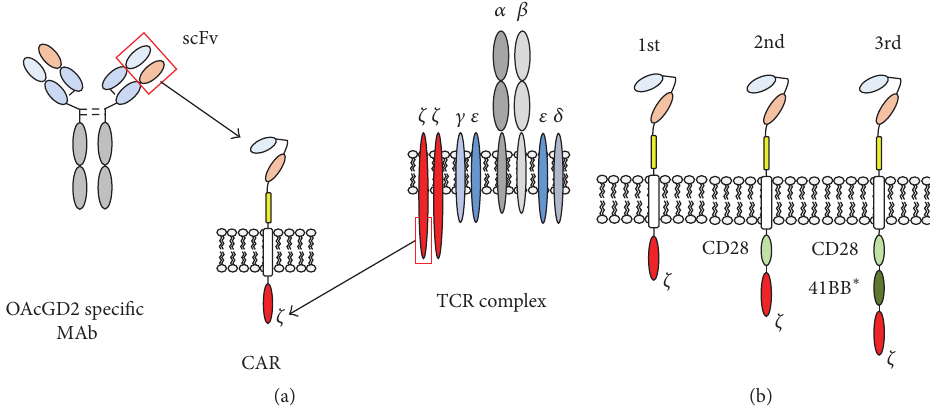
Figure 3: Structure of O -acetyl-GD2 CAR examples. (a) An O- acetyl-GD2-specific mAb derived scFv is linked through a spacer and a transmembrane domain to the T cell receptor (TCR) complex CD3 𝜁 chain intracellular signaling domain. (b) Additional costimulatory endodomains are shown in 2nd- and 3rd-generation CARs derived from CD28 or CD28 and 41BB, respectively. ∗ 41BB may be exchanged to other domains such as OX40 or